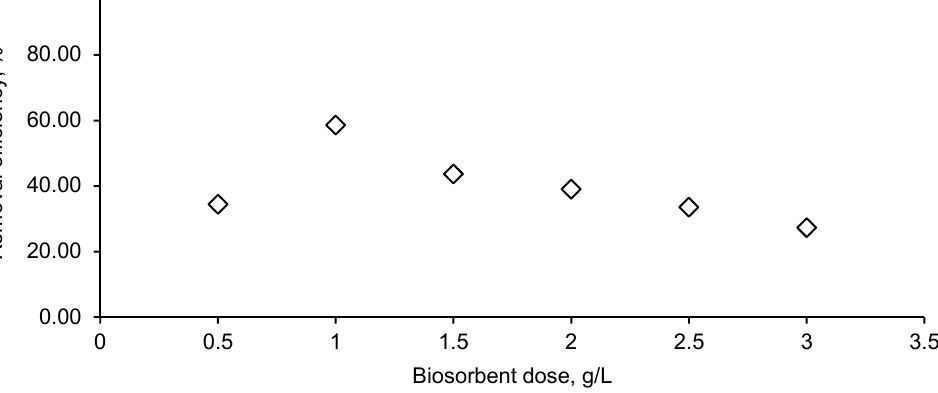
Figure 8. Biosorbent dose influence on CPX removal efficiency (CPX solution volume: 25 mL; CPX initial concentration: 50 mg/L; CPX initial solution pH: 4).